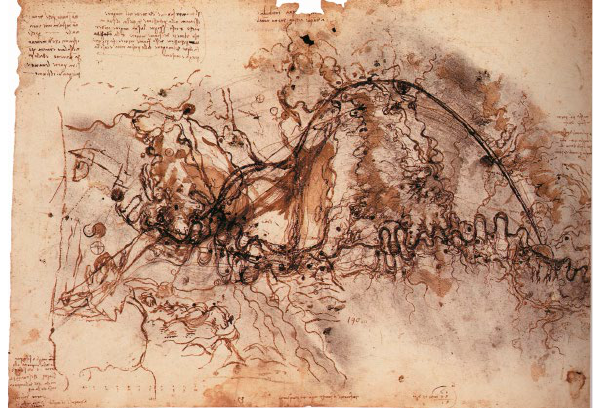
Figure 12. Map of the Lower Valdarno , Windsor, Royal Library, 12279.